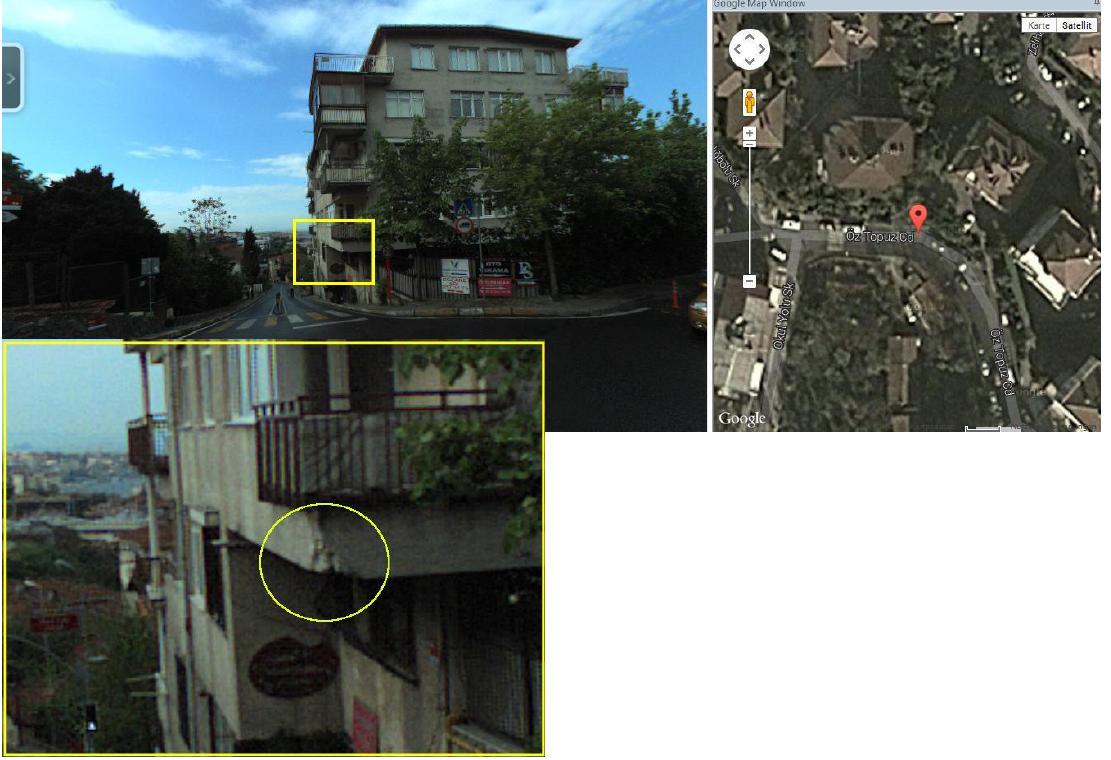
Figure 12. Example of an omnidirectional image showing a (non-structural) damage of a building. The distance between building and camera is of about 20 m. The damage is visible in the lower part of the image, circled in yellow. The upper right inset shows the geographical location of the captured omnidirectional